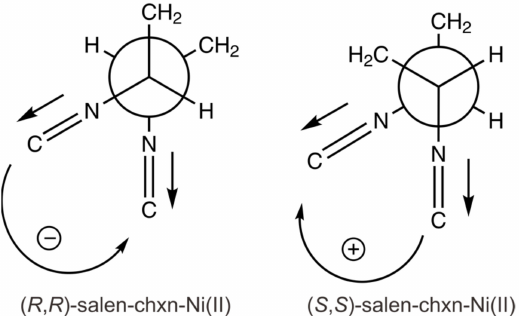
Figure 11. The two coupled C=N stretching transition dipole moments are indicated for the ( R , R )- salen-chxn-Ni(II) and ( S , S )-salen-chxn-Ni(II), providing the negative and positive exciton coupling couplets,